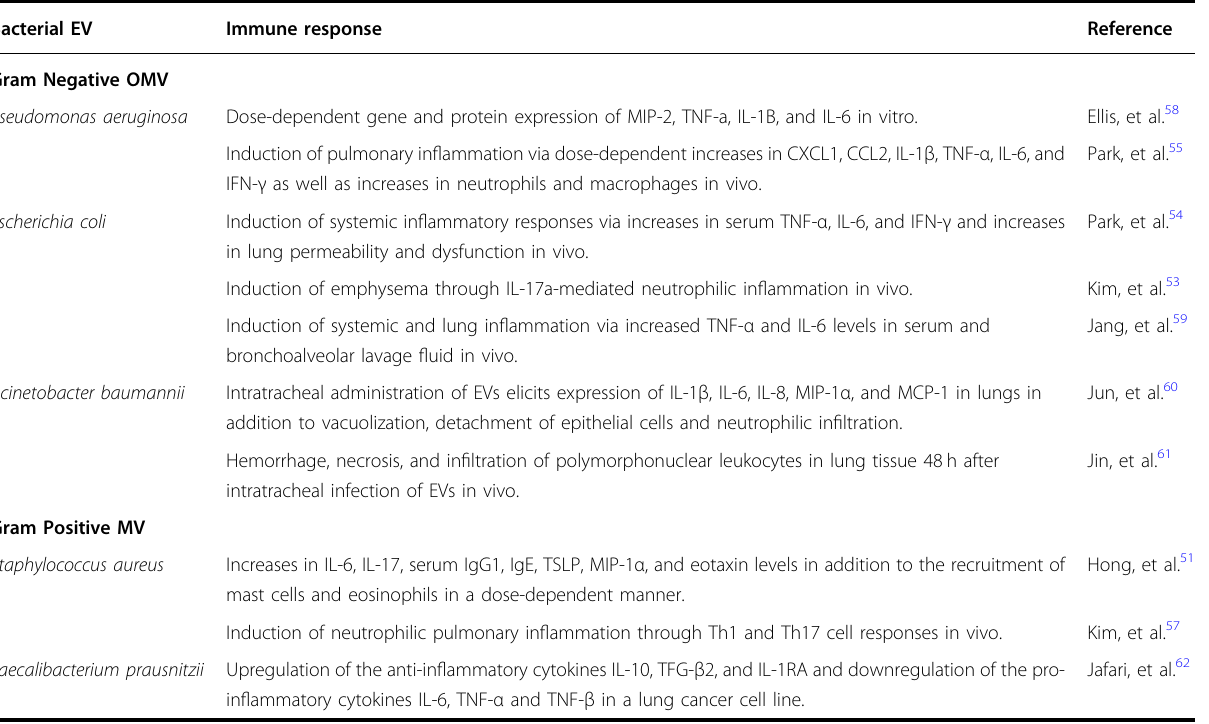
Table 1 Immune responses to bacterial extracellular vesicles. Bacterial EV Immune